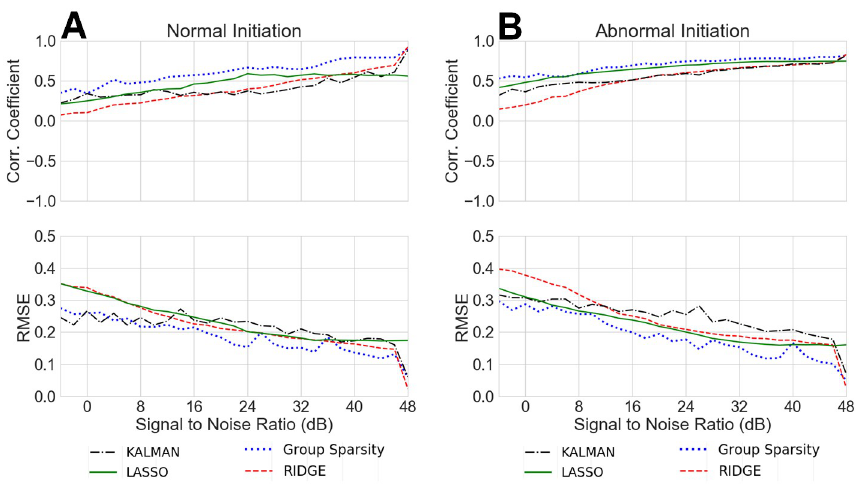
Fig 6. Average correlation coefficient and RMSE for different noise levels (All methods). A) Normal simulation inverse results average correlation coefficient and RMSE as a function of AWGN noise level, B) Abnormal simulation inverse results average correlation coefficient and RMSE as a function of AWGN noise